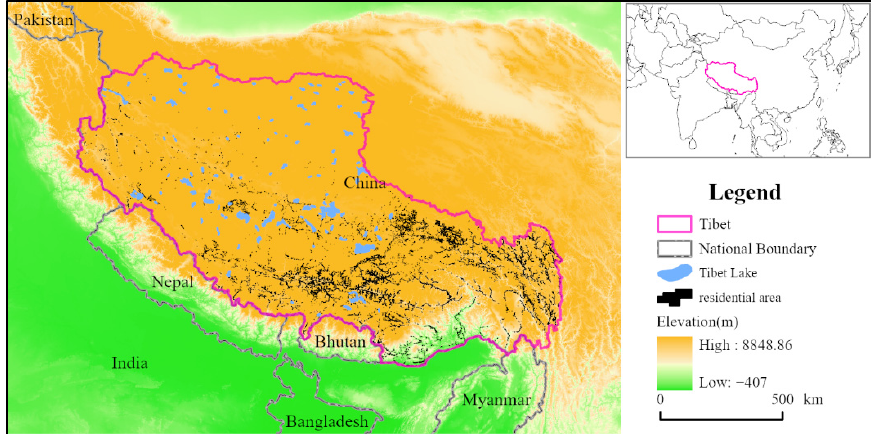
Figure 2. Overview of the study area in the background of